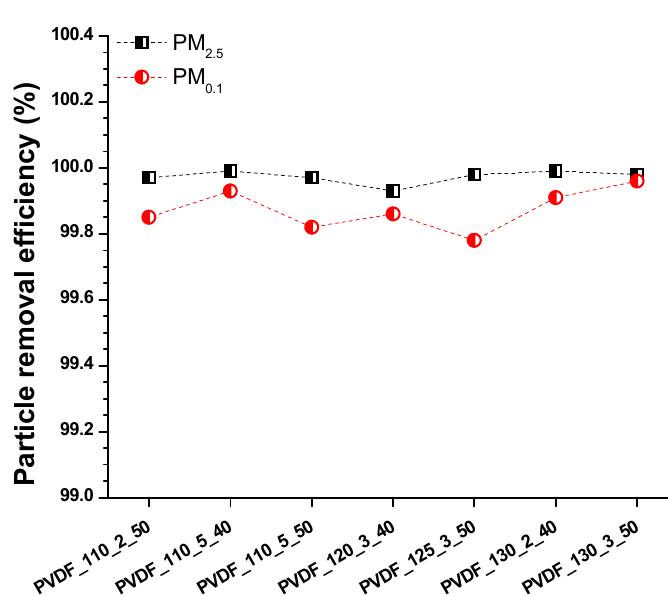
Figure 11. Particle removal efficiency for the various laminated nanofibrous membranes according to PM 2.5 and PM 0.1 .